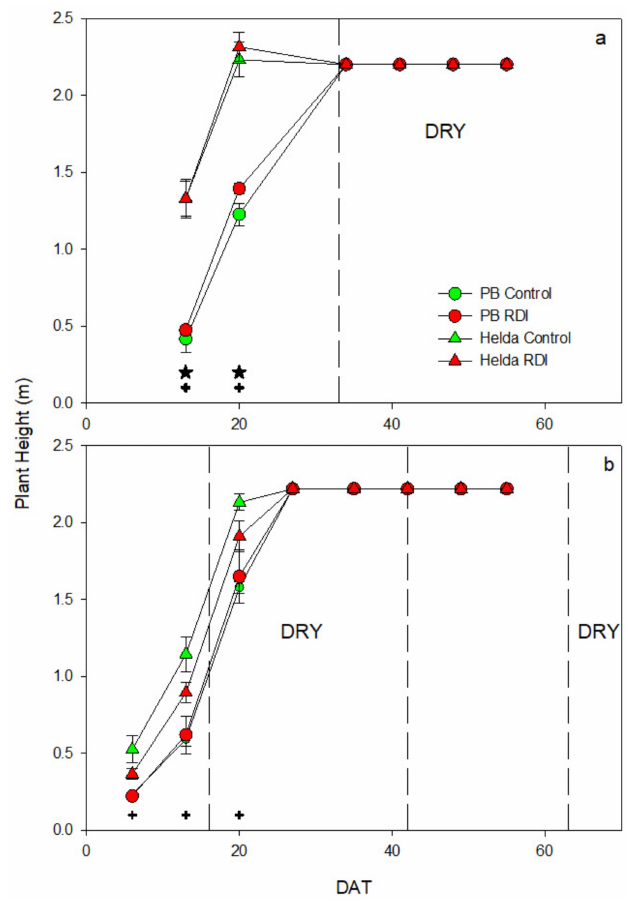
Figure 6. Pattern of plant height during the 2020 ( a ) and 2021 ( b ) seasons. Each point is the average of four measurements. Vertical lines represent the standard error. Triangles, cv Helda (upside down, Control; upright, RDI); Circles, cv Perfeccion Blanca (red, Control; orange, RDI). Asterisks (irrigation) and crosses (cultivar) indicate significant differences on those dates ( p < 0.05). The word “dry” indicates a period without